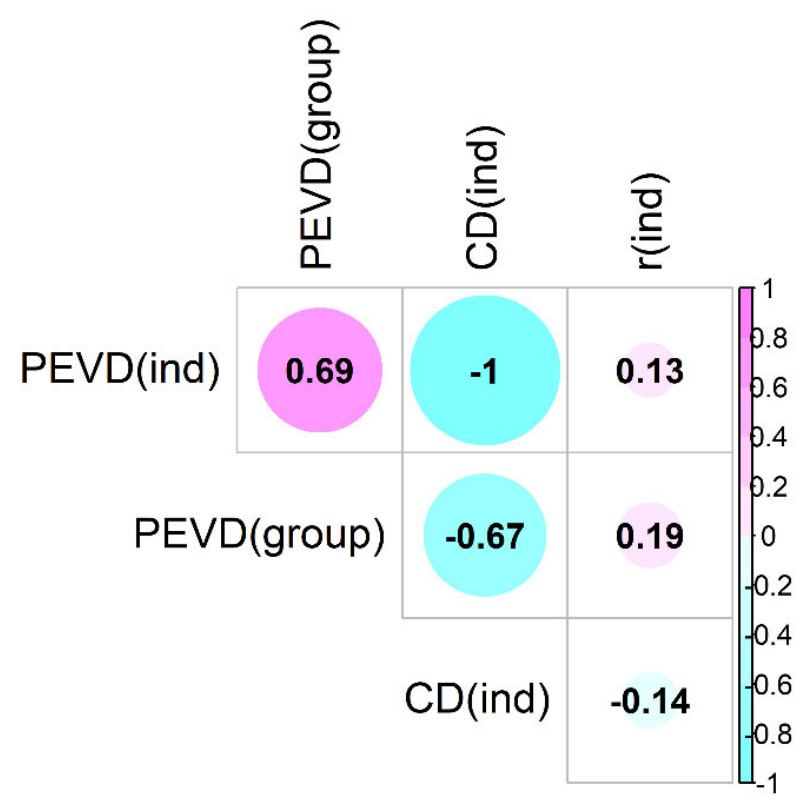
Figure 8. Correlation between four different connectedness statistics.